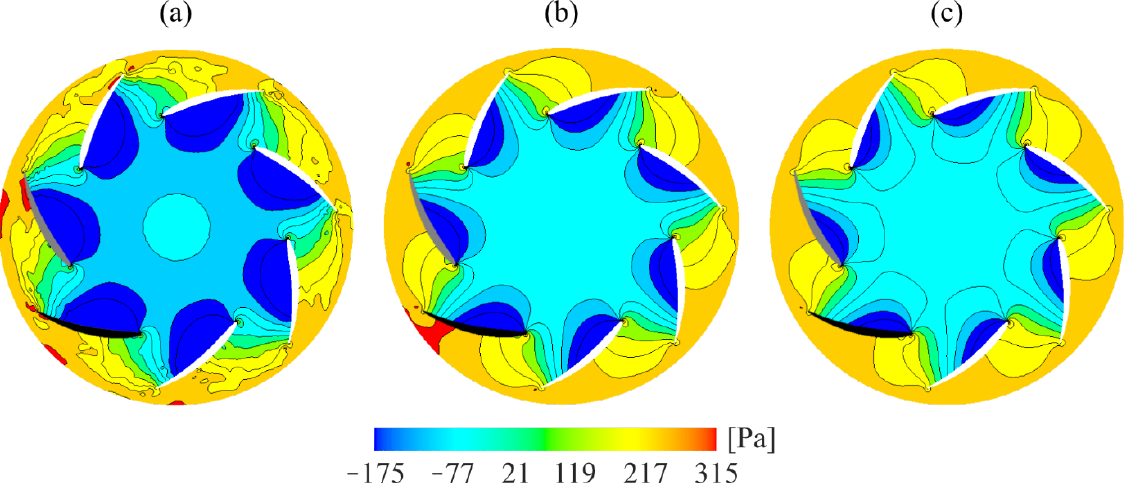
Figure 8. The instantaneous pressure 𝑝 in ( a ) Plane 1, ( b ) Plane 2, and ( c ) Plane 3. Blade 2 is colored gray and Blade 3 is colored black.